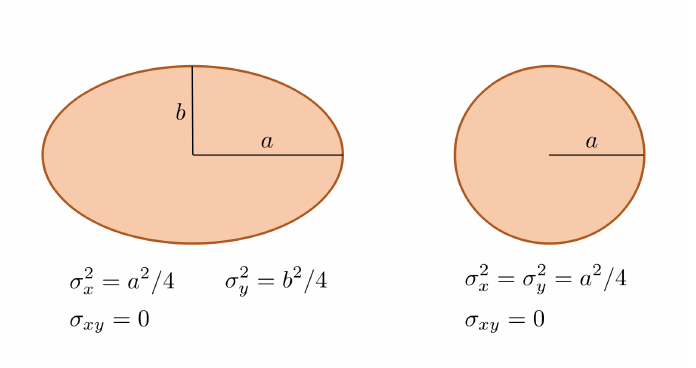
Figure 7. Relation of variances and semi-principal axes for an axis-aligned ellipse (circle). In the case that the ellipse is not axis-aligned, the relation is similar but using the eigenvalues of the covariance matrix.